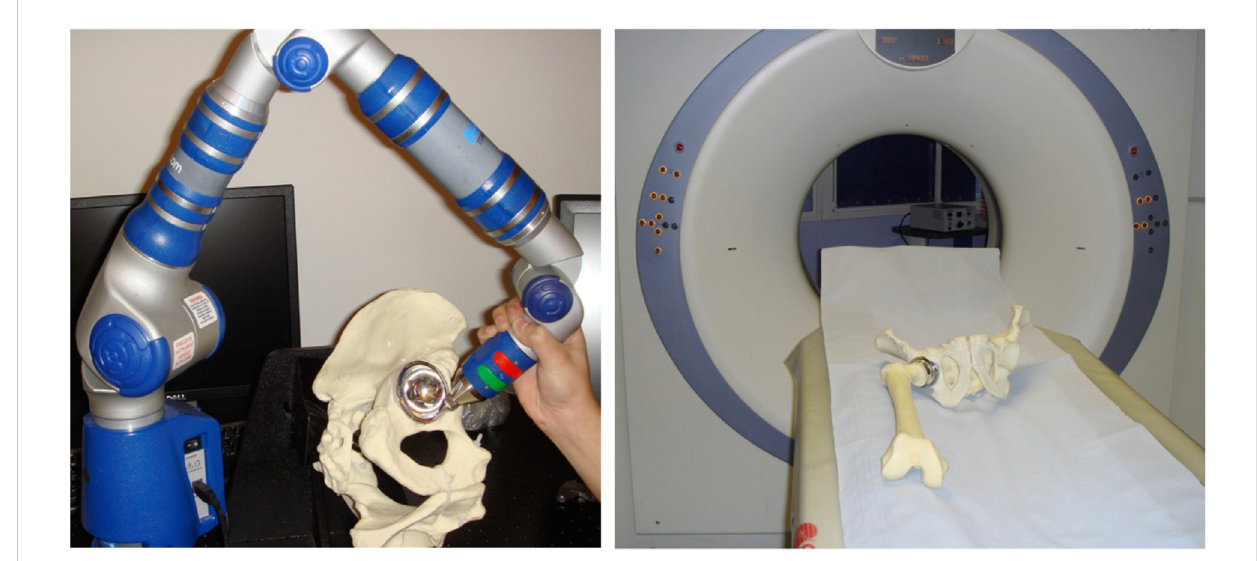
FIGURE 1 (Left) The orientation of the metal acetabular cup implanted in the pelvic Sawbone model being measured by the digitising arm. (Right) The model placed on the CT scanner table with the fi ducials (hexagonal fully threaded titanium screws) placed on landmarks for robust